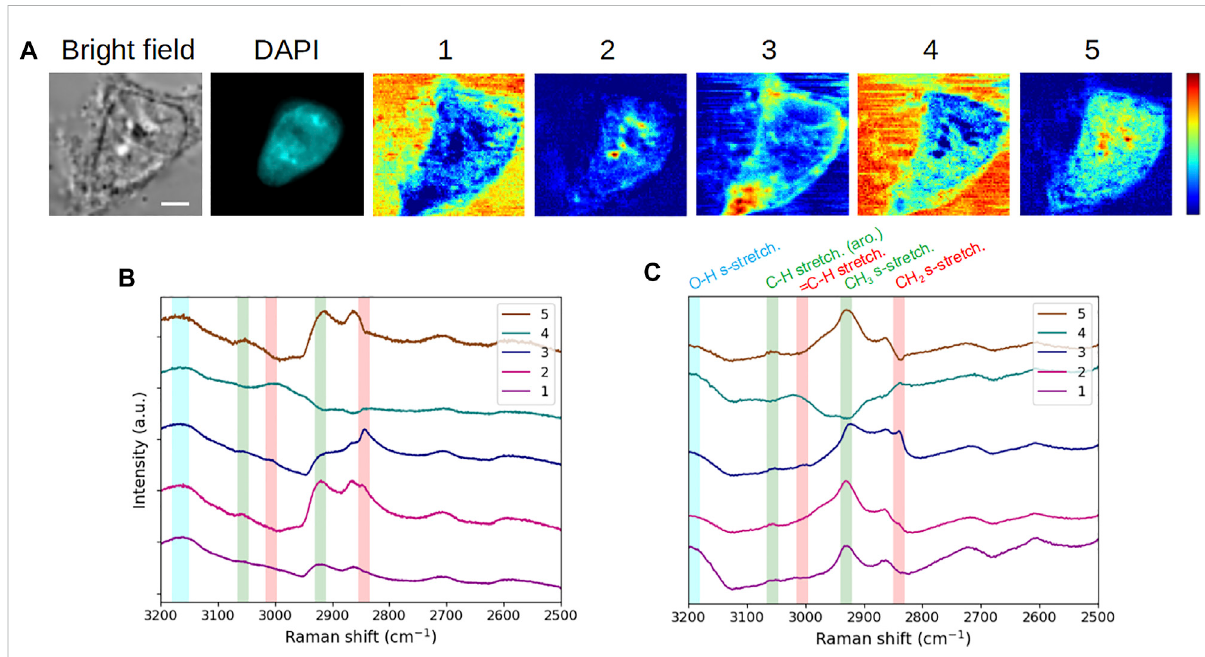
FIGURE 2 Application and spectroscopic validation of the MC 2 approach for the analysis of a fi xed interphase HEK293 cell. ( A) Bright- fi eld and fl uorescence images and concentration maps obtained for the fi ve computed components. The scale bar corresponds to 5 μ m and applies to all images. (B) Spectra extracted for these fi ve components. (C) Raman-like spectra after MEM processing, with the following vibrational modes highlighted: